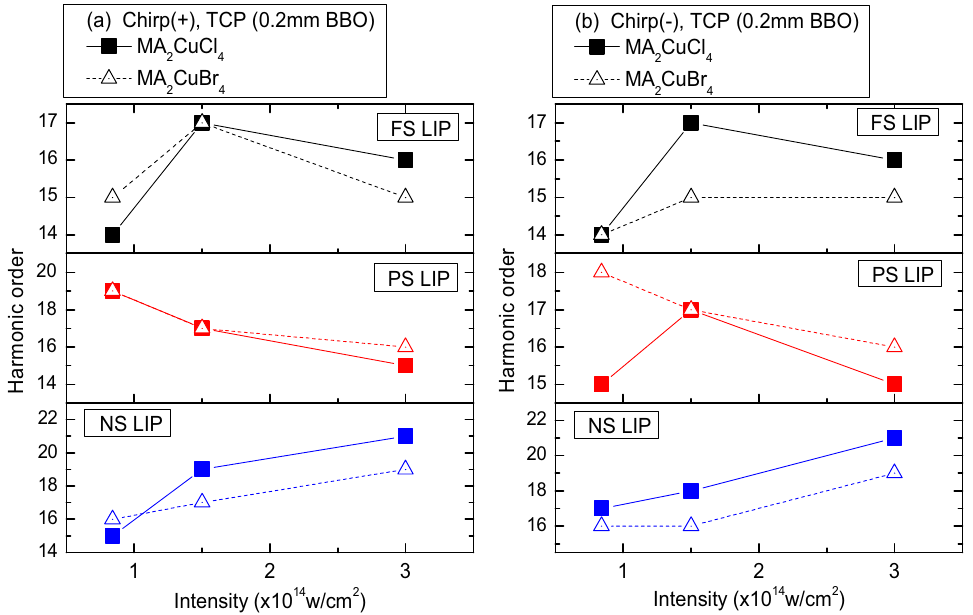
Figure 5. The cut-off N c position dependence on the type of heating pulse and the chirp sign in case of the TCP scheme. X axis corresponds to 800 nm laser pulse intensity.